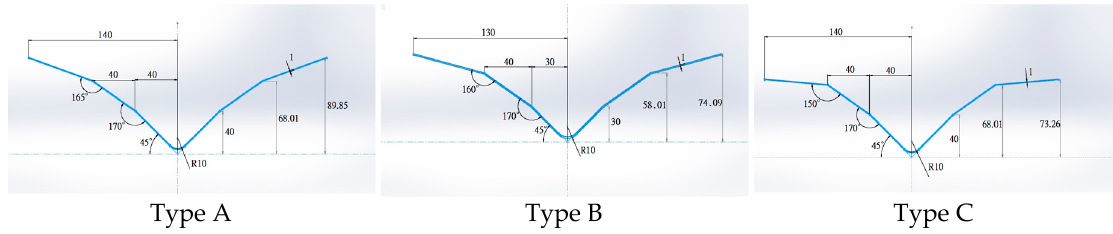
Figure 8. Optimized optical reflectors and their parameters.